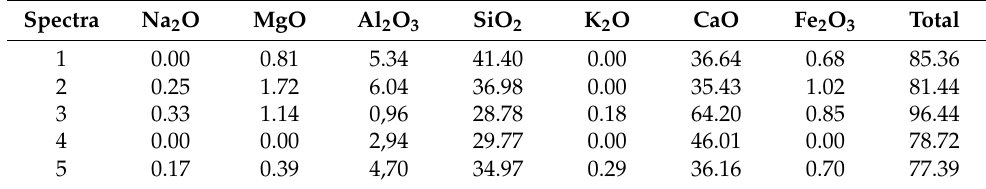
Table 4. Results of the typical microphases analysis (images of the analysis are in Figure 6c,d).